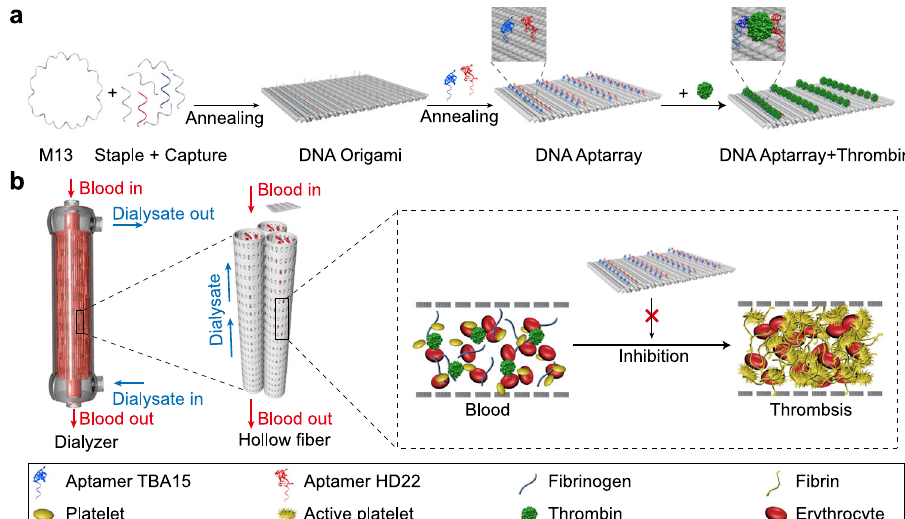
Fig. 1 Design of an aptamer-functionalized DNA origami nanoarray for anticoagulation in hemodialysis. a Schematic illustration of the construction of the aptamer-loaded nanoarray by DNA origami, and the speci fi c binding and inhibition of thrombin. Single-stranded M13mp18 DNA (M13) is folded by annealing with staple strands and capture strands (staple + capture) to form a rectangular DNA origami. Two types of thrombin-binding aptamers, TBA15 and HD22, are loaded onto the DNA origami by hybridization with capture sequences (blue and red) that extend from the surface of the rectangular DNA template (DNA Aptarray). The Aptarray can speci fi cally and ef fi ciently bind thrombin molecules, inhibiting coagulation. b Schematic representation of the utilization of the DNA Aptarray for ef fi cient anticoagulation in hemodialysis. Fresh human blood from healthy donors along with the Aptarray is pumped via mechanical roller pump to a dialysis column (Dialyzer) through the closed extracorporeal circuit, while the dialysate fl ows through the device and then discarded. Aptarray captures thrombin molecules and ef fi ciently inhibits their catalytic activities, eliciting robust anticoagulatory effects in the ex vivo extracorporeal hemodialysis circuit.